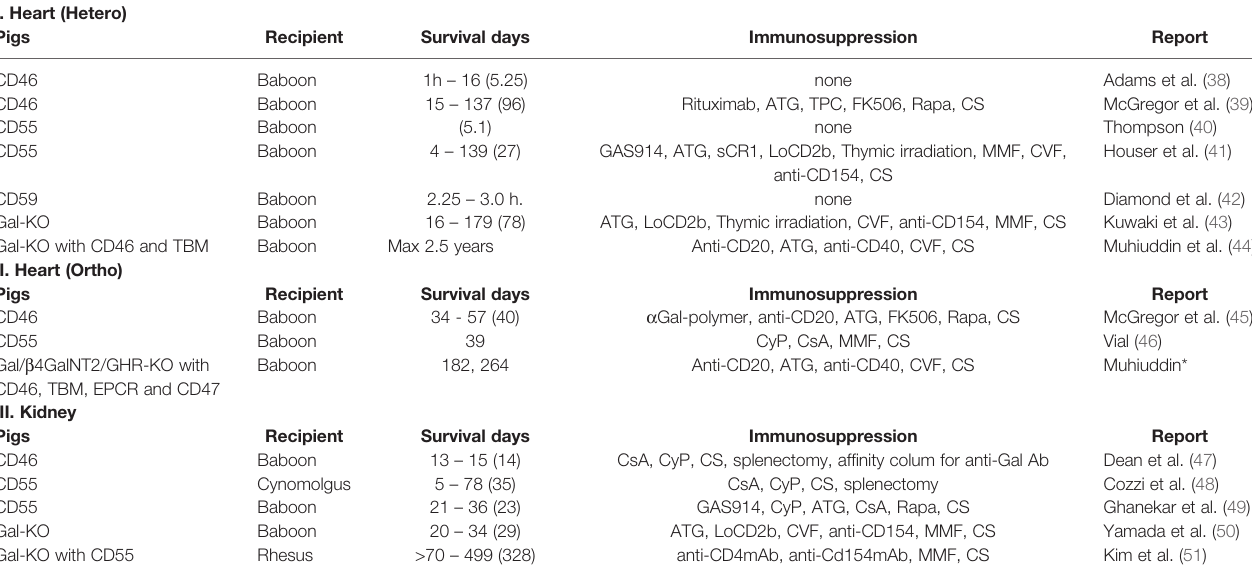
TABLE 1 | Report of CRP transgenic pig heart and kidney transplantation into primates, and comparison with Gal-KO. In addition, the best record for reference. I. Heart (Hetero)